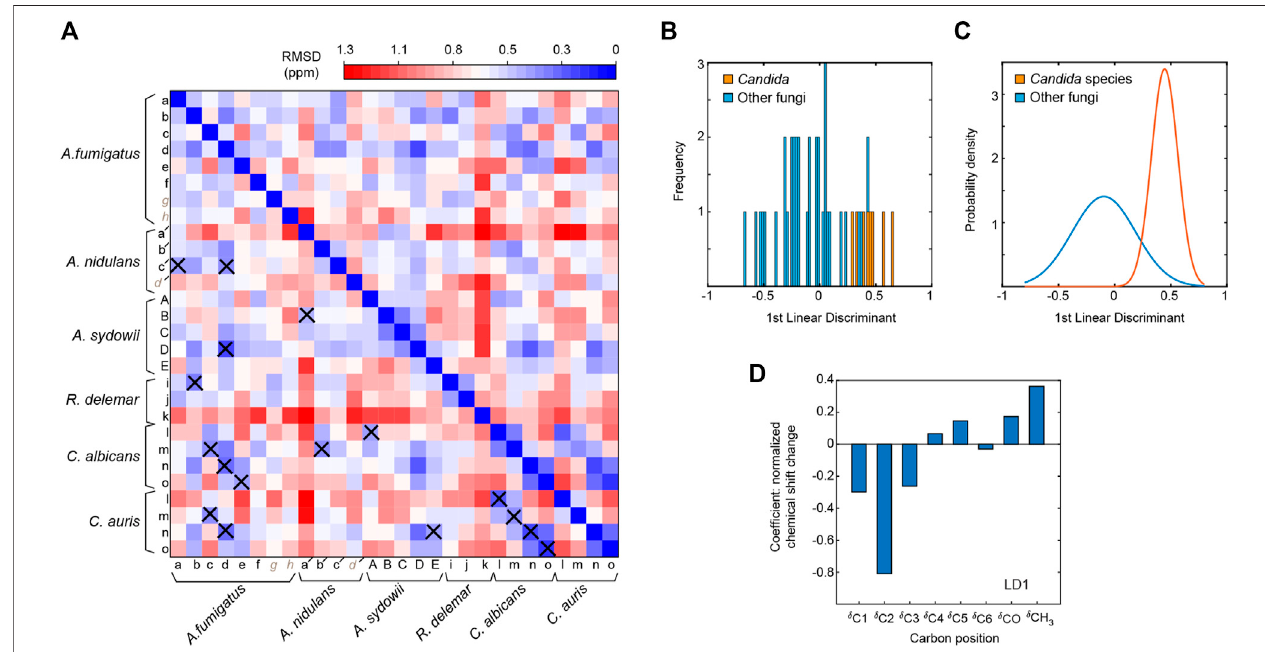
FIGURE 5 | Comparison of chitin forms identi fi ed in different fungal species. (A) Chemical shift RMSD heatmap comparing the chitin forms observed in different fungi. Good correlations with RMSD of less than 0.5 ppm are highlighted using crosses. (B) Linear discriminant analysis with Candida fungi ( C. albicans and C. auris ) classi fi ed differently from other fungal species, with linear discriminant 1 (LD1) scores shown in a histogram. This panel mainly shows the frequency in which LD1 scores fall into a particular range (the width of each bar). (C) Gaussian probability distributions of LD1 scores. The Candida data falls into a smaller range than the other fungi,therefore,thereisamuchhigherprobabilitythata Candida specieswillfallneartheirstatisticalmean. (D) LD1loadingscorrespondingtothechemicalshiftsofeach carbon site.